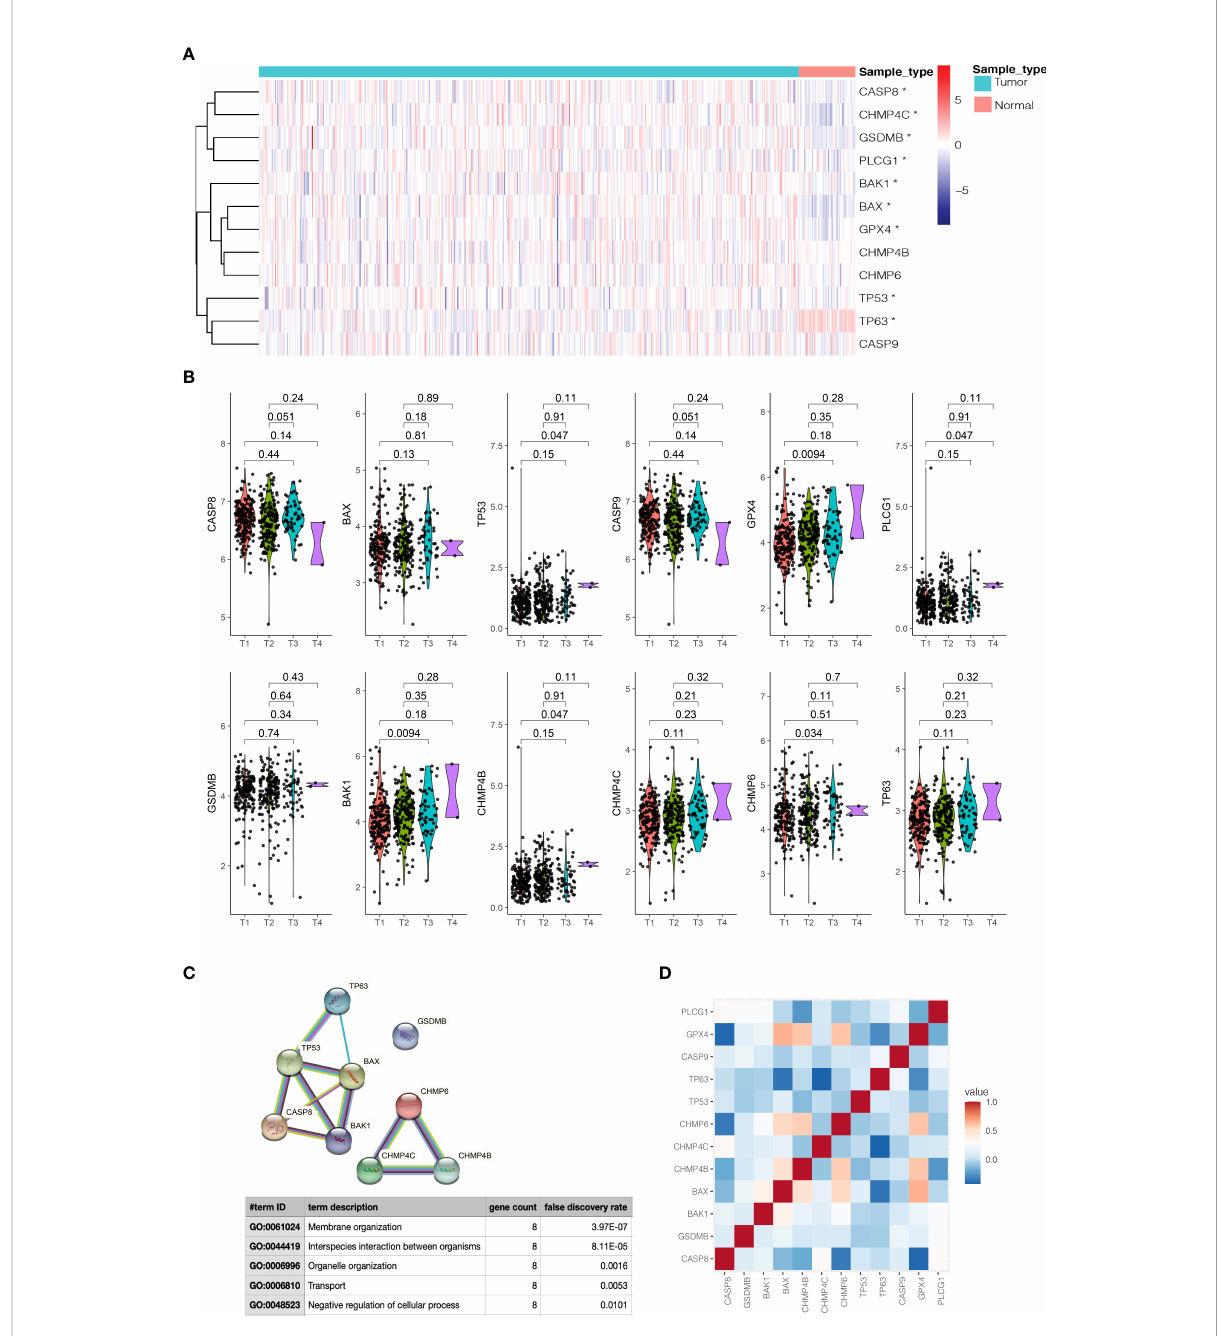
FIGURE 2 Expressions of 12 prognostic pyroptosis-related genes(PPGs) and clinicopathological features. (A) The heatmap(navy:low exression level;red:high expression level) of 12 PPGs between the tumor(blue) and the normal group(pink). P values were shown as: *P<0.05. (B) The violin plots of the relationship between 12 PPGs expression and T stage. (C) The PPI network generated by STRING database showing the interactions of the pyroptosis-related genes. (D) The Pearson correlation heatmap of these prognostic pyroptosis-related